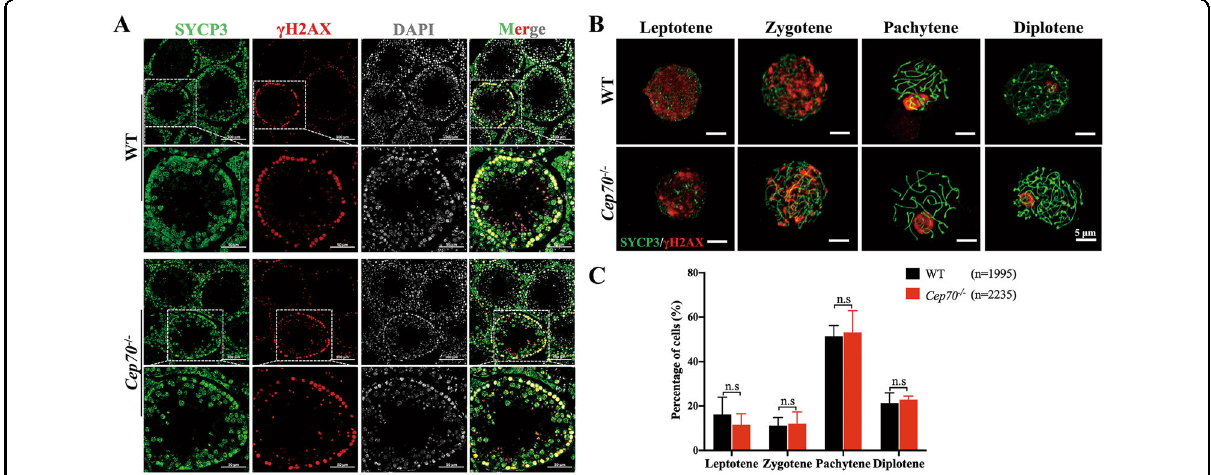
Fig. 3 CEP70 is dispensable to the prophase of meiosis I during spermatogenesis. A Immuno fl uorescence staining of SYCP3 (green) and γ H2AX (red) in sections of testes from the WT and Cep70 − / − mice. DAPI indicates the nucleus. Scale bar: 100 μ m (up), 50 μ m (down). B Immuno fl uorescence staining of SYCP3 (green) and γ H2AX (red) in chromosome spreads of spermatocytes from the testes of 10-week-old WT and Cep70 − / − male mice. Scale bar: 5 μ m. C Quanti fi cation of the proportion of meiotic stages in WT and Cep70 − / − spermatocytes. The numbers marked in the bars represent the percentage of cells at indicated meiosis stage (leptotene, zygotene, pachytene, and diplotene). For each genotype, three mice were analyzed. p -values were calculated by Student ’ s t -test. Data are presented as the mean ± SD, n.s. not statistically signi fi